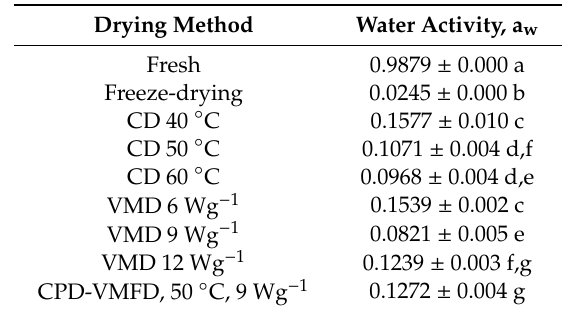
Table 5. Water activity of dried S. crispus dehydrated using di ff erent